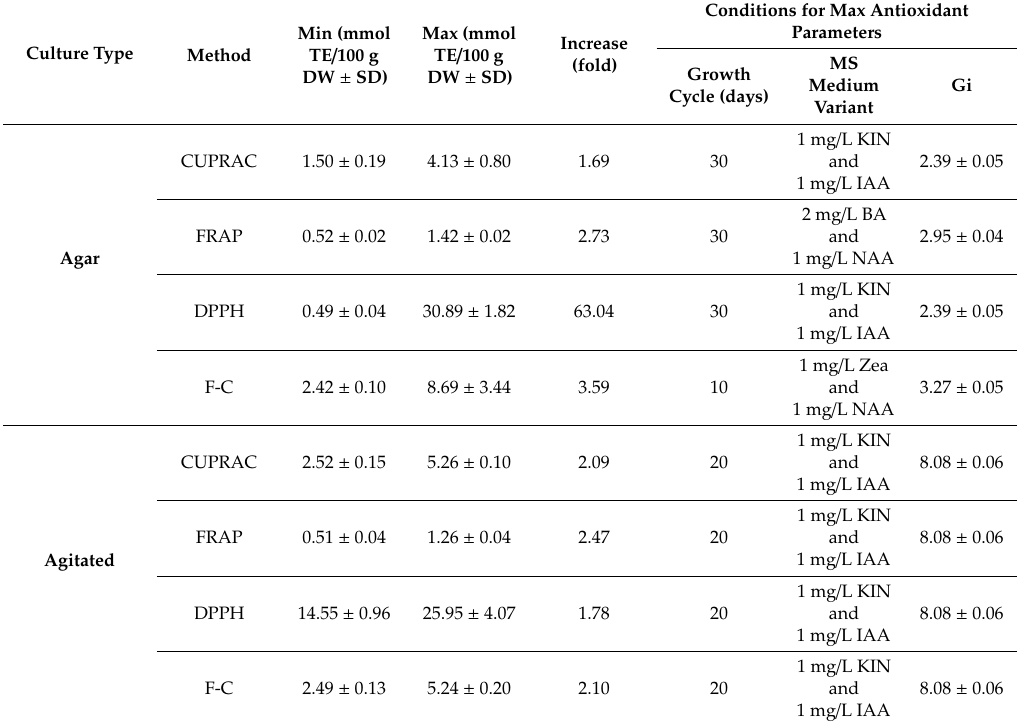
Table 4. The maximal antioxidant potential estimated by CUPRAC, FRAP and DPPH methods and periods and composition of cytokinins and auxins in the MS media variants in microshoot cultures. Values represent the mean ( ± SD) of five samples ( n = 5). Table corresponding with Tables